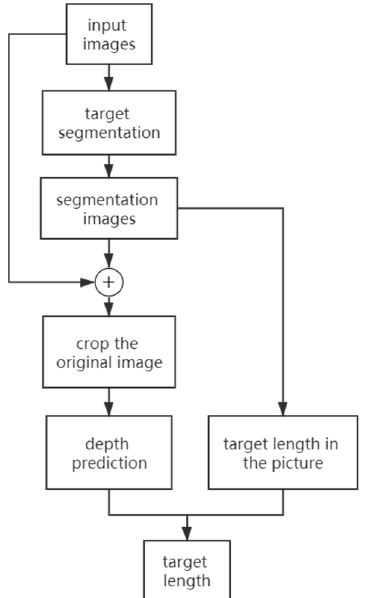
Figure 1. Flowchart of object body length analysis.